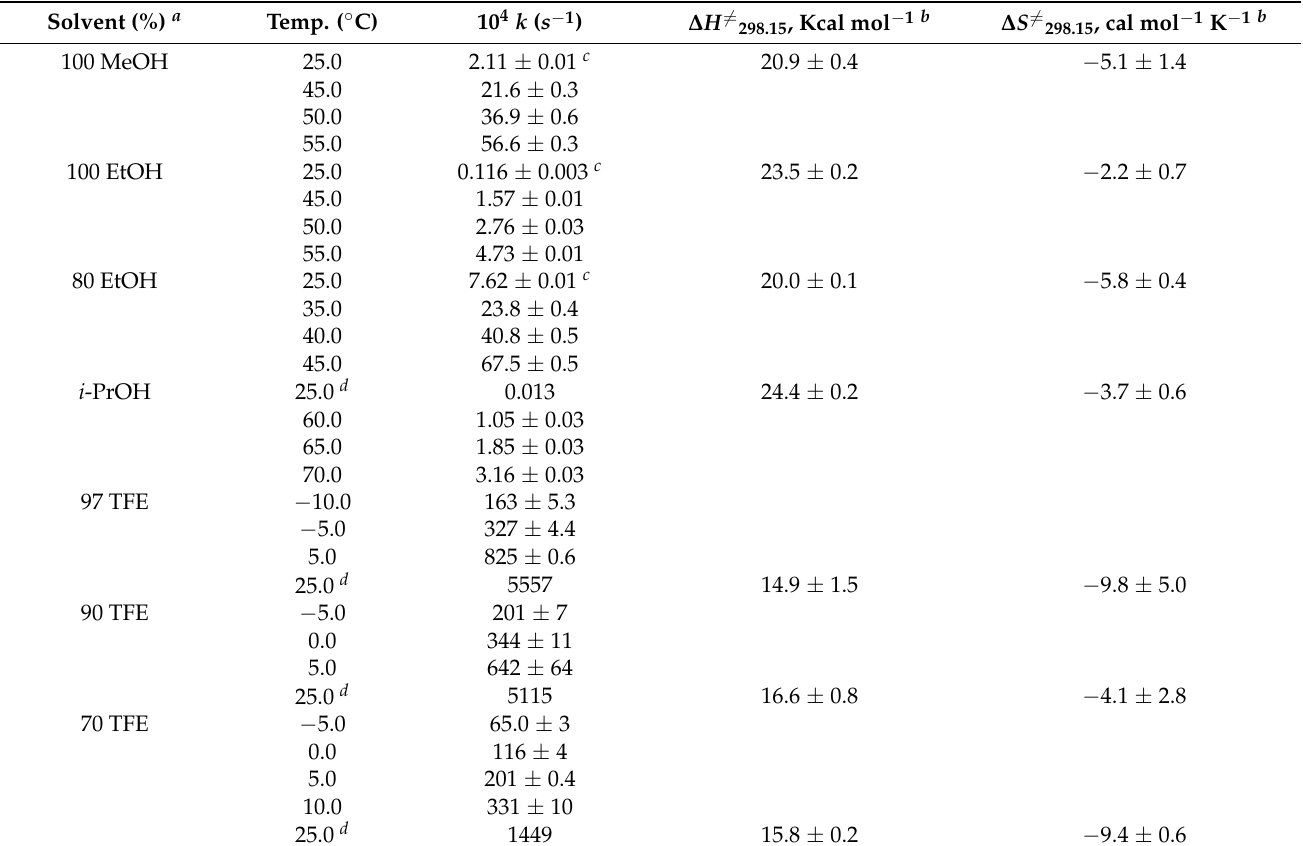
Table 2. Rate constants and activation parameters ( ∆ H (cid:54) = and ∆ S (cid:54) = ) for solvolysis of 1 in pure and aqueous binary solvents at various temperatures.